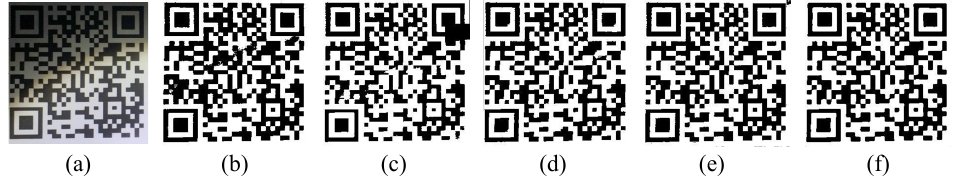
Figure 15. The original image and experimental results of different algorithms: ( a ) Original image; ( b ) Sauvola’s algorithm [6]; ( c ) Yao’s algorithm [18]; ( d ) Di’s algorithm [8]; ( e ) Chen’s algorithm [13]; ( f ) Proposed method.